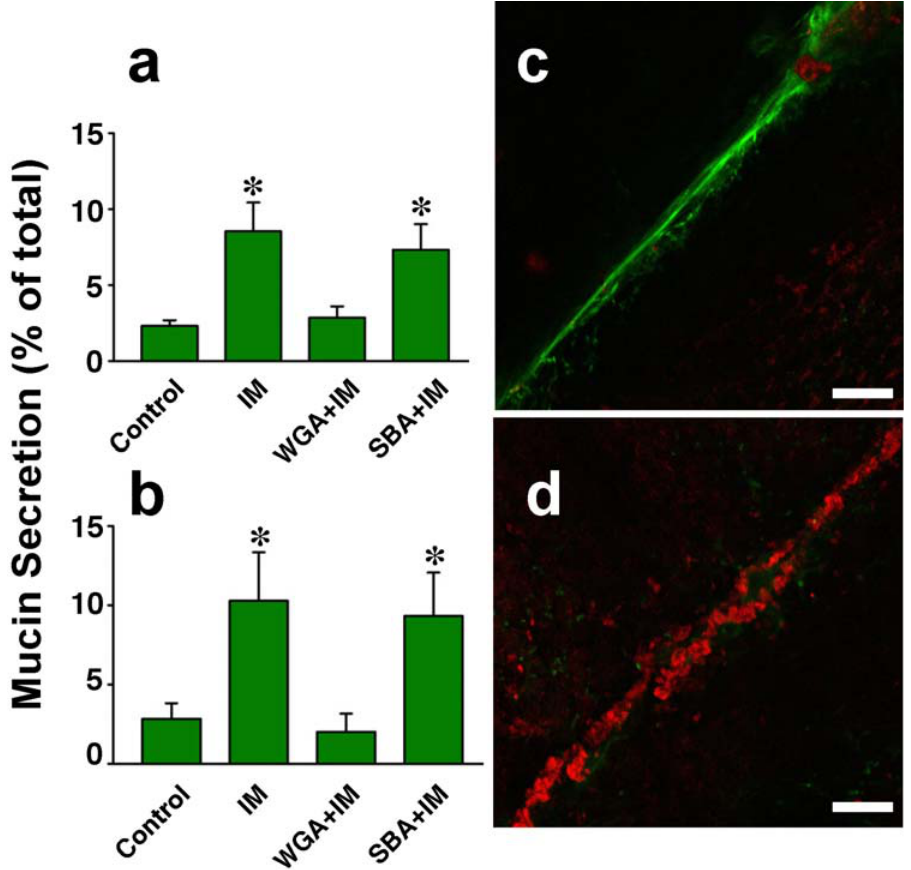
Figure 3. Lectins also potently inhibit mucus secretion. a,b) WGA blocks secretion of mucus by cultured SSM cells. Adherent cells were treated with WGA ( WGA + IM ) or SBA ( SBA + IM ) at a concentration of 100 m g/ml for 10 min and then incubated with a mucus-secretion inducing stimulus, Ca 2 + ionophore ( IM ) (Ionomycin, 1 m M, 60 min). Control cells were not treated with ionophore or lectin ( Control ). The medium conditioned by these cells was then harvested and the content of mucus present quantitated using an ELLA assay employing either WGA (a) or UEA (b) as the mucus ligand. All treatments differing significantly from the control ( Control ) are decorated with an asterisk, n=8, 6 S.D., p # 0.001 (Panel a), # 0.001 (Panel b), Kruskal- Wallis test. c) An excised, untreated control segment of mouse colon was scratched to induce plasma membrane disruptions in surface goblet